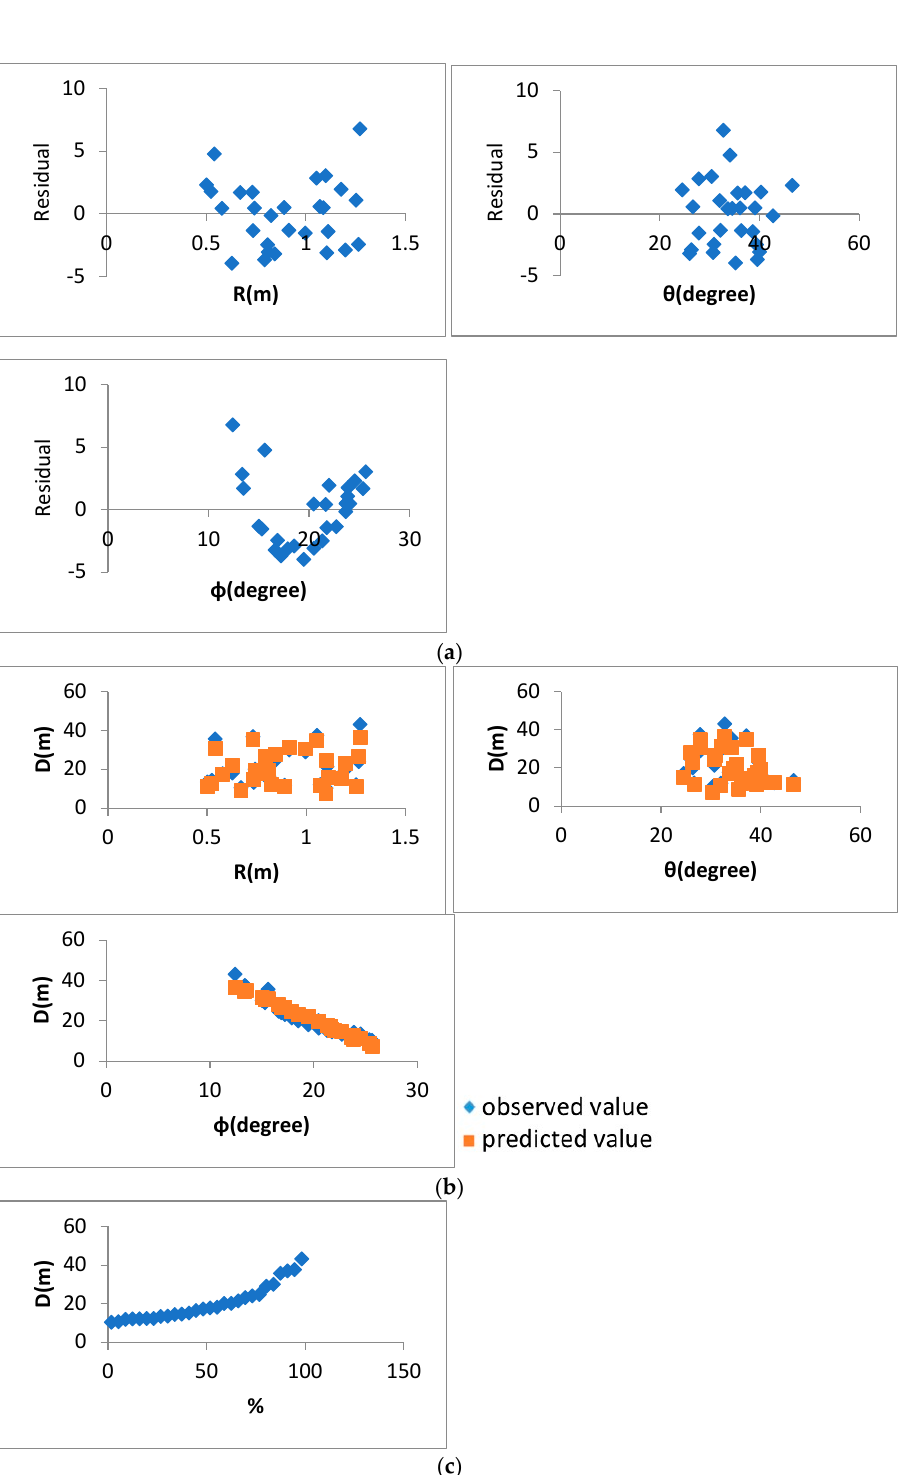
Figure 8. The results of the fit analysis between the nonlinear predicted value and the observed value, where ( a ) is the residual of each parameter, ( b ) is the sample regression line of each parameter, and ( c ) is the normal probability. D is the thickness of the sliding soil layer, R is the landslide triggering rainfall, θ is the slope of sliding surface, and ϕ is the equivalent friction angle.